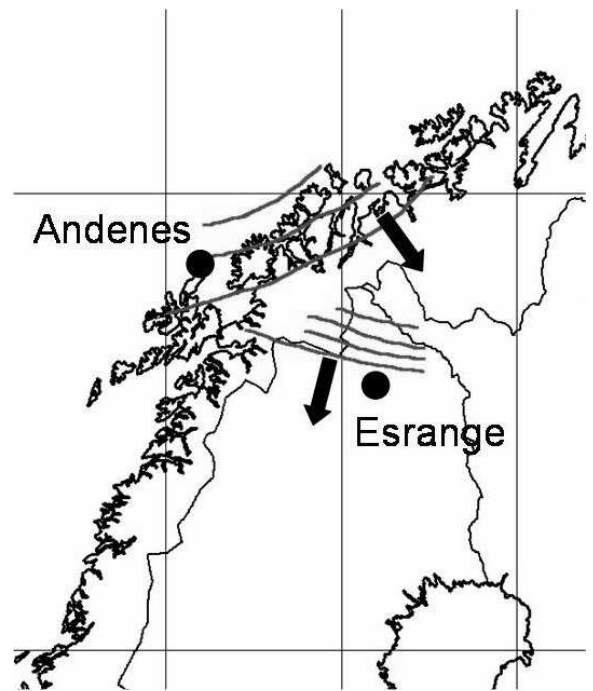
Fig. 4. Geographic map showing northern Scandinavia and the two observation sites participating in the campaign. Projected onto the map are the two waves observed on the night of January 27/28 (at 16:41 UT) and their respective direction of propagation. Wave 1 propagated towards S-SW and is moving across the Esrange meteor radar field of view. In contrast, wave 2 initially progressed overhead Andenes on a SE heading towards Esrange.